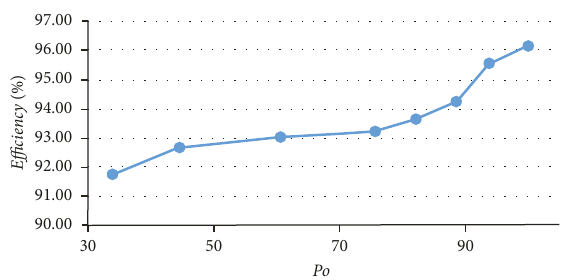
Figure 18: The efficiency of the DS-HS converter, when U